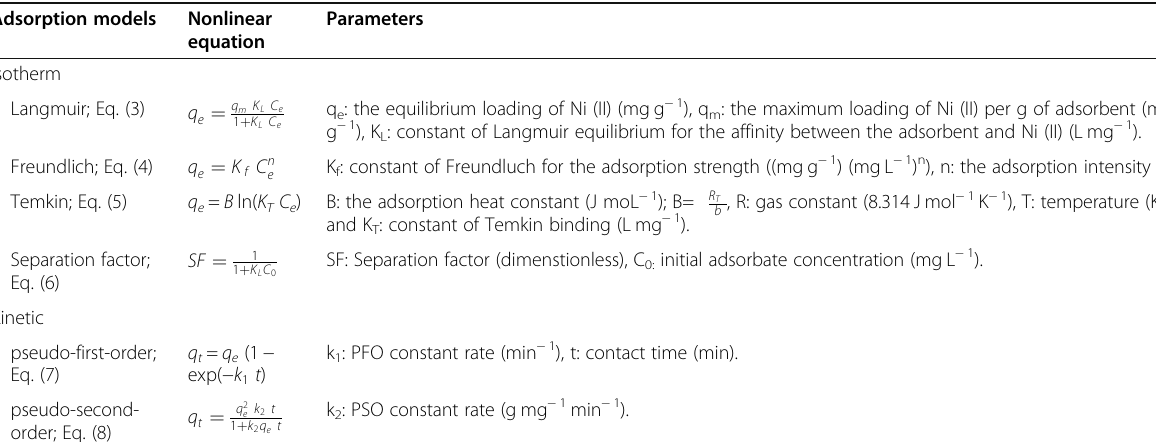
Table 1 Isotherm and kinetic adsorption models Adsorption models Nonlinear Parameters equation